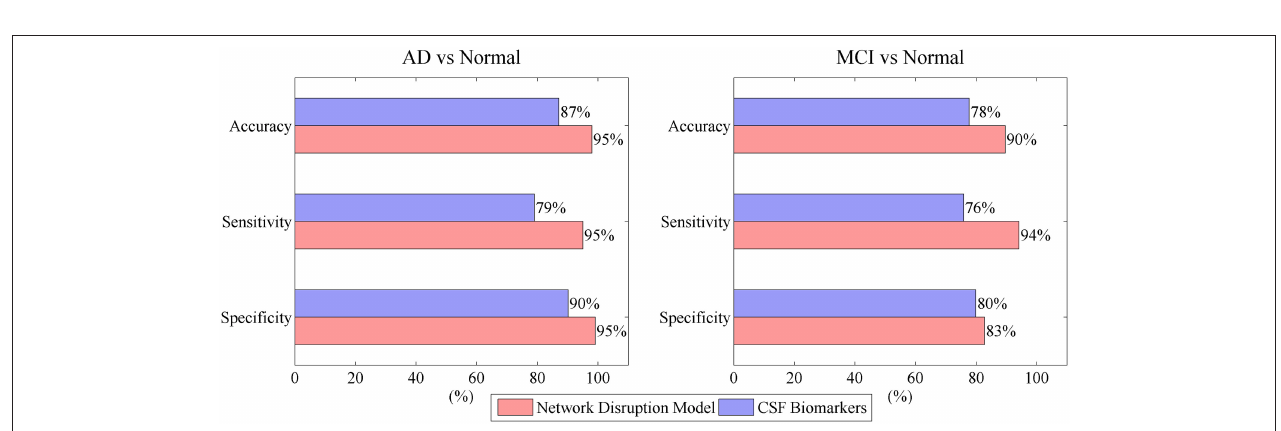
FIGURE 4 | The relationship and correlation analysis between estimated mini network disruption probability and MMSE. As plot AD, MCI, and normal shown, mini network disruption probability coincides with 1/MMSE. In plot regression, least squares regression is used to analyze the correlation between mini network disruption probability and MMSE.